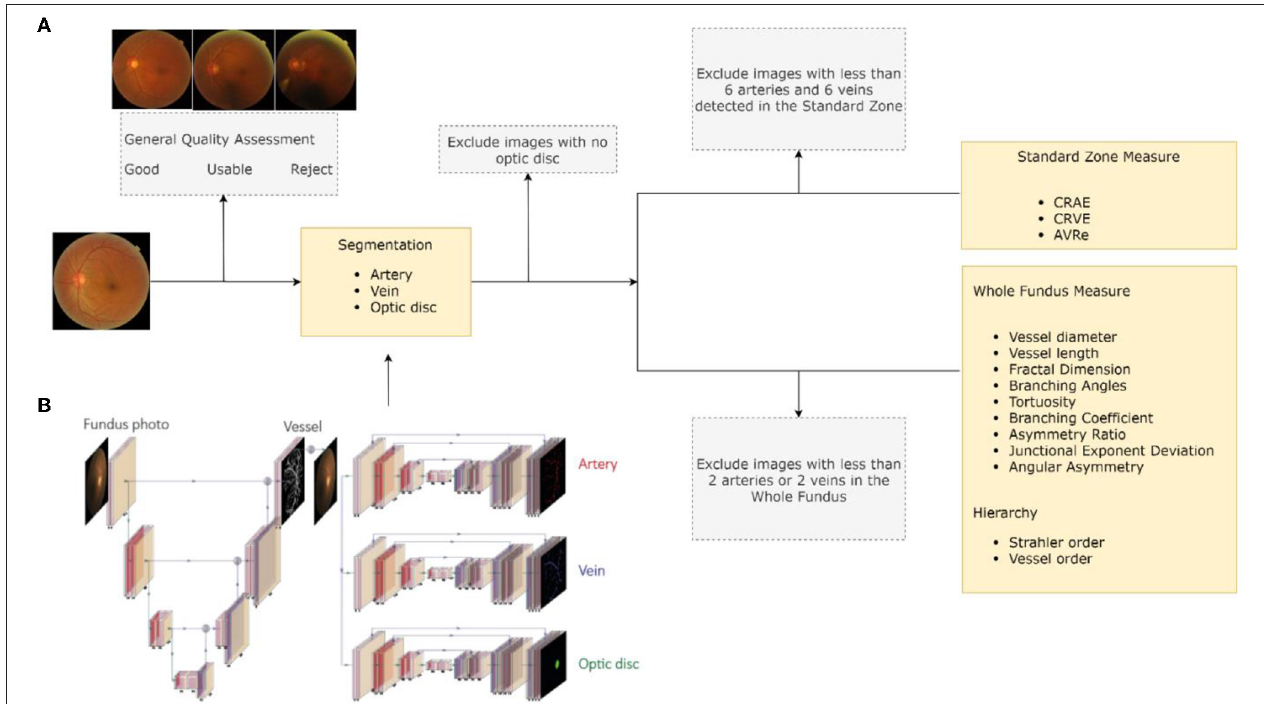
FIGURE 1 | Software development flowchart. (A) Retina-based Microvascular Health Assessment System (RMHAS) workflow. (B) The multi-branch U-Net used in RMHAS for segmentation. The trunk generates an intermediate retinal vessel feature map, which is concatenated with the input image and divided into three separate branches for retinal artery, vein, and optic disc segmentation.